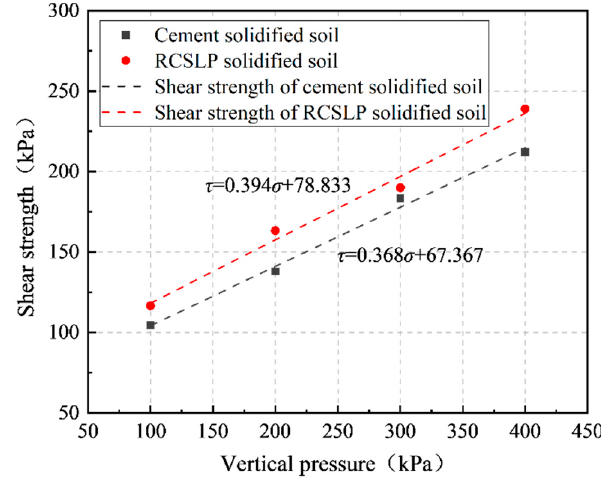
Figure 11. Shear strength of the solidified soil after 7 days.